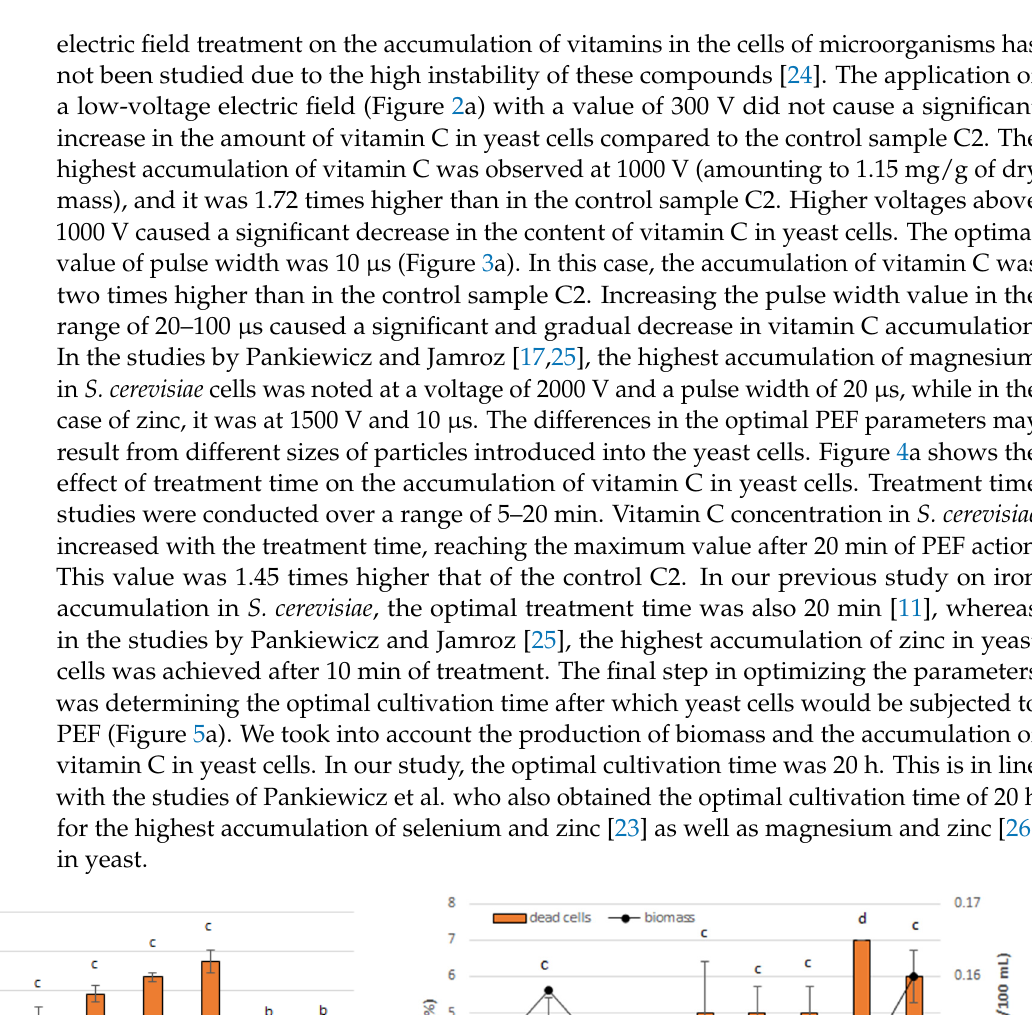
( b ) Figure 3. Effect of pulse width on vitamin C accumulation in yeast cells ( a ). Effect of pulse width on the number of dead yeast cells and on biomass ( b ). C1—control culture without vitamin C added to the medium and PEF treatment, C2—control culture with vitamin C added to the medium (5 mg/mL medium) and without PEF treatment, orange bars—cultures treated with PEF (vitamin C, 5 mg/mL medium; voltage, 1000 V; treatment time, 10 min; number of pulses, 600; after 20 h of cultivation). Each value is the mean ± standard deviation ( n = 3). Bars with the same letter (a–d) are not signifi- cantly different ( p < 0.05). ( a )